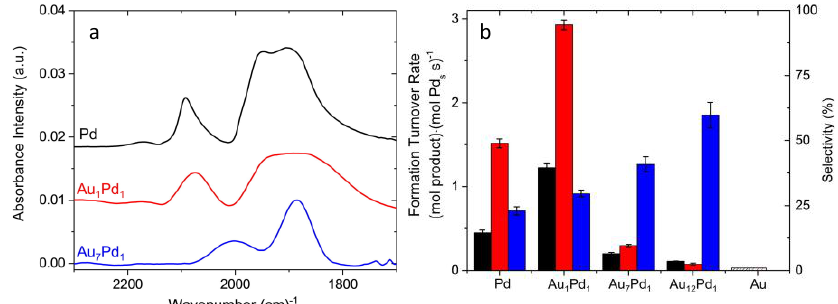
Figure 10. ( a ) Infrared spectra of CO adsorbed on Pd (black; 0.5 wt% Pd), Au 1 Pd 1 (red; 0.5 wt% Pd), and Au 7 Pd 1 (blue; 0.014 wt% Pd) obtained after saturating surfaces under flowing CO (~15 min in 5 kPa CO, 96 kPa He, 303 K) and purging gas-phase CO with He (101 kPa, 47.5 cm 3 min − 1 , 303 K). Spectra are the average of 128 scans with a 4 cm − 1 resolution. Peak heights were normalized by the atop bound CO feature at 2090–2000 cm − 1 . ( b ) Steady-state H 2 O 2 (black) and H 2 O formation rates (red) and selectivity towards H 2 O 2 (blue) on catalysts with different ratios of Au to Pd (55 kPa H 2 , 60 kPa O 2 , 305 K, 30 cm 3 min − 1 20% v / v methanol). Dashed bars indicate that rates were undetectable. Reprinted from J. Catal., 357, N. M. Wilson, P. Priyadarshini, S. Kunz, D. W. Flaherty, Direct synthesis of H 2 O 2 on Pd and Au x Pd 1 clusters: Understanding the effects of alloying Pd with Au, 163–175, Copyright (2018), with permission from